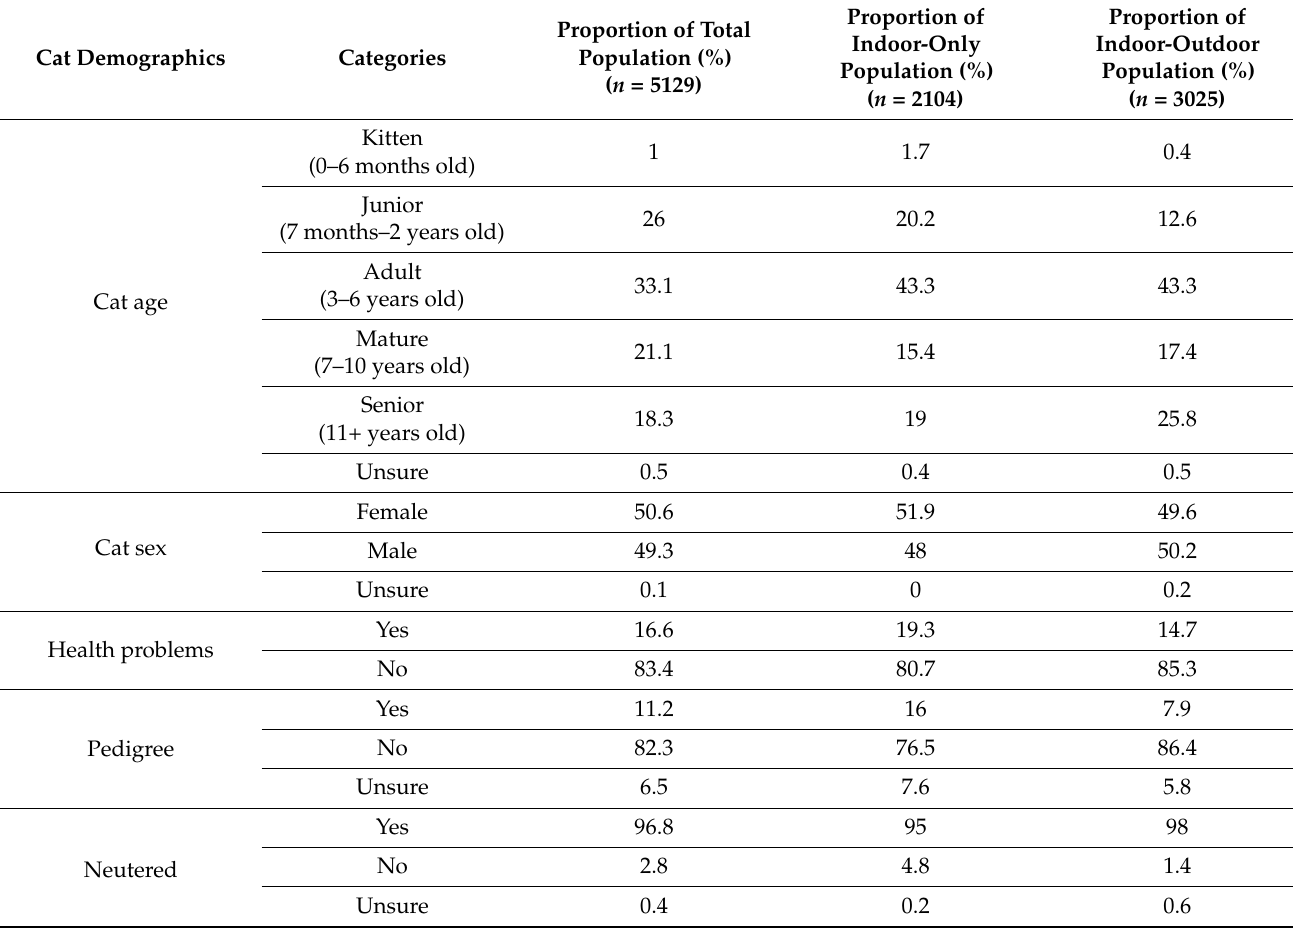
Table 2. Cat demographics and their management practices as reported by 5129 owners. The percentages for all cats can be seen, alongside a breakdown of those with an indoor-only lifestyle ( n = 2104) and an indoor-outdoor lifestyle ( n =